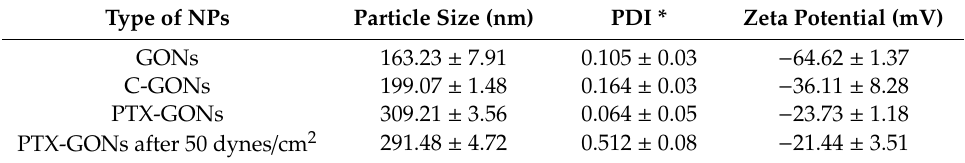
Table 1. Physicochemical properties of gelatin–oleic NPs (GONs), coumarin-6-loaded GONs (C-GONs), and paclitaxel-loaded GONs (PTX-GONs). Data are expressed as mean ± SD, n =